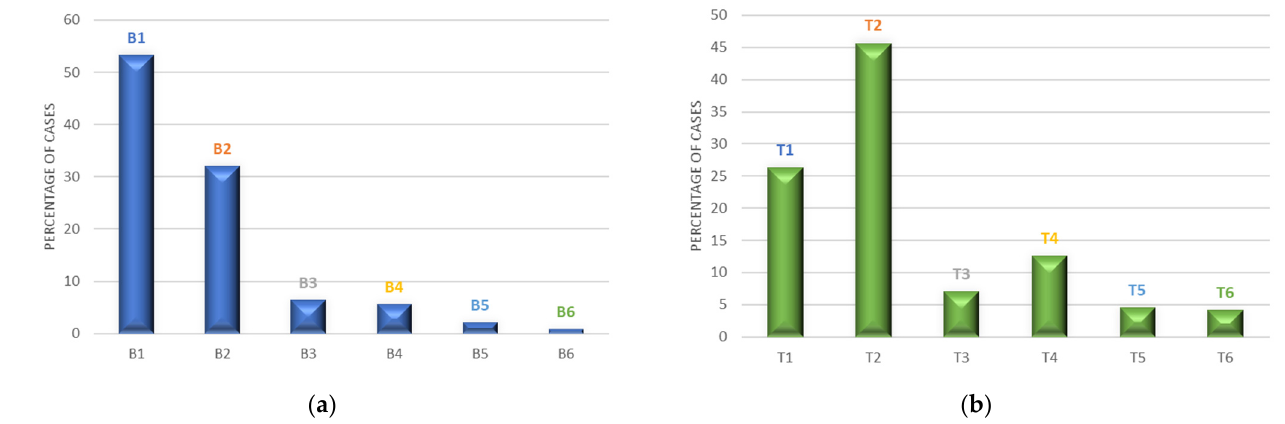
Figure 6. Frequency of ( a ) baric objects and ( b ) types of atmospheric processes in the middle troposphere (500 hPa) according to SWPp data in Crimea for the period of 1976–2020: B1—southern cyclones, B2—trough, B3—northwestern cyclones, B4—cyclones over Ukraine, B5—undefined, B6— Atlantic cyclones; T1—western, T2—mixed, T3—central, T4—eastern, T5—zonal, T6—undefined.